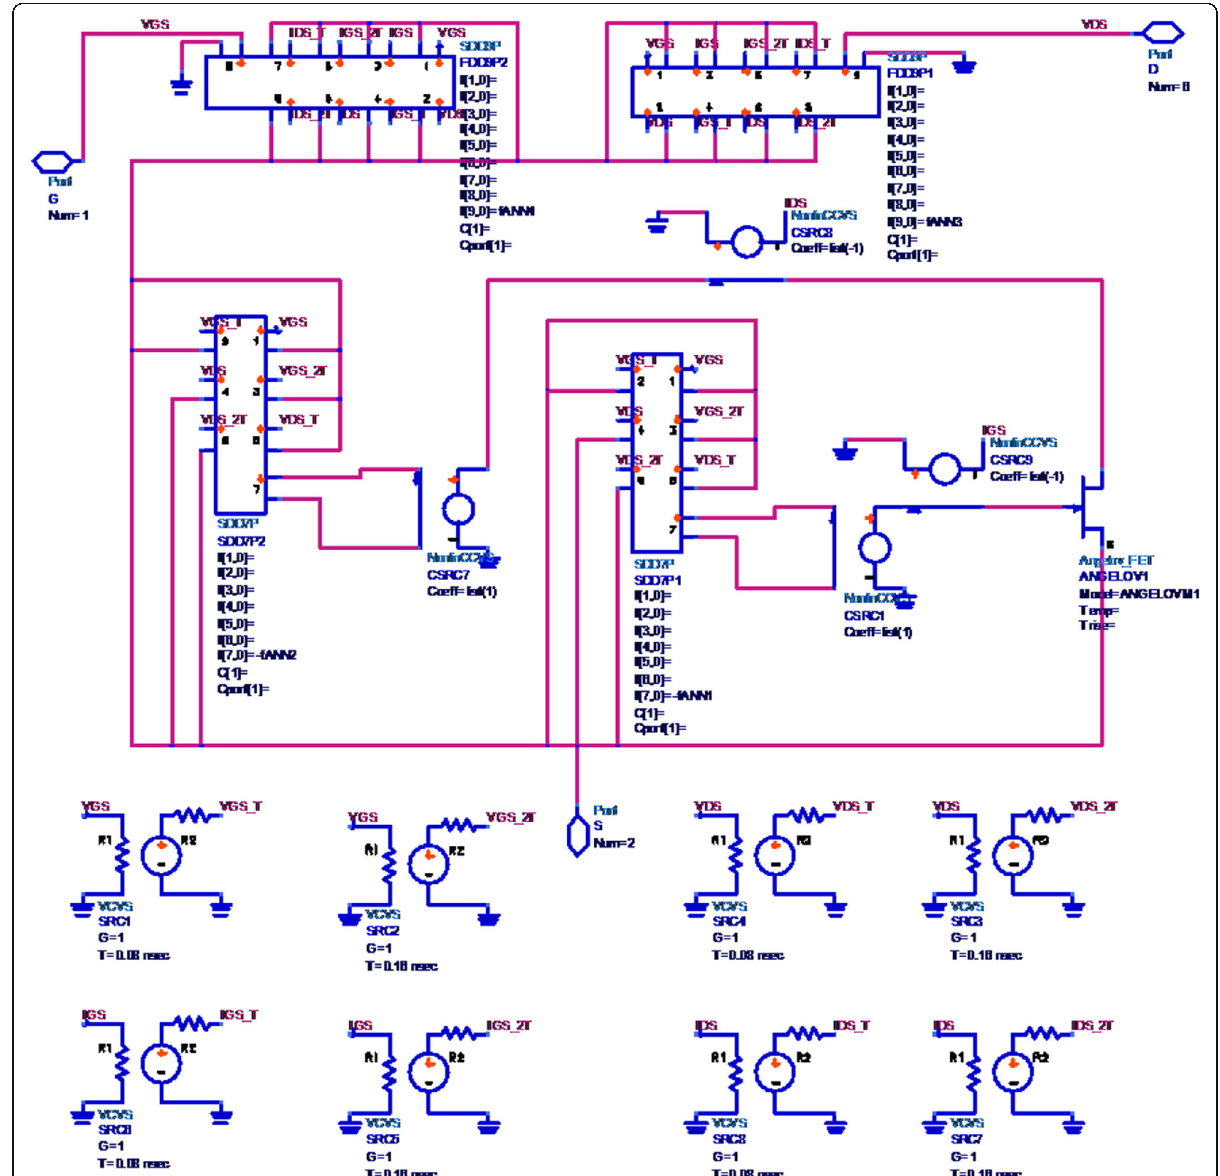
Fig. 4 Structure of the general Neuro-SM model with two delay buffers in